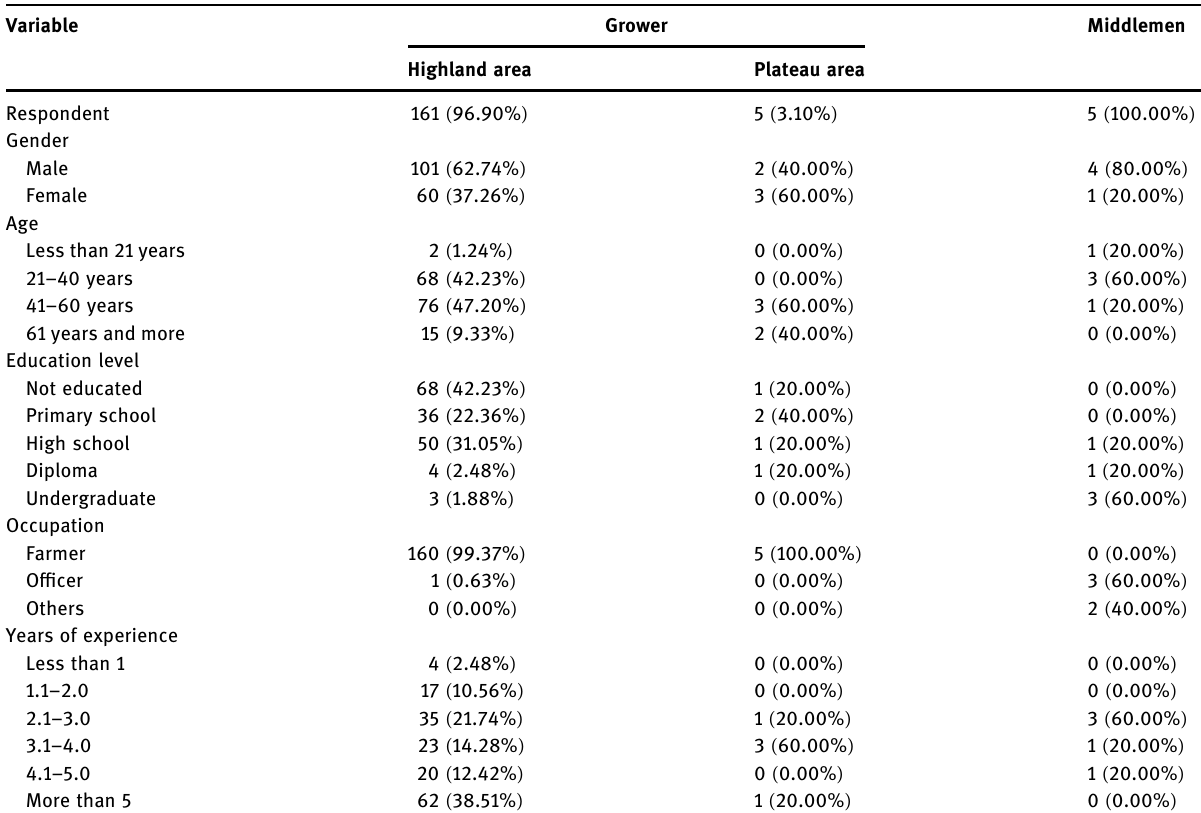
Table 1: General information of mulberry supply chain actors ( count and % total )